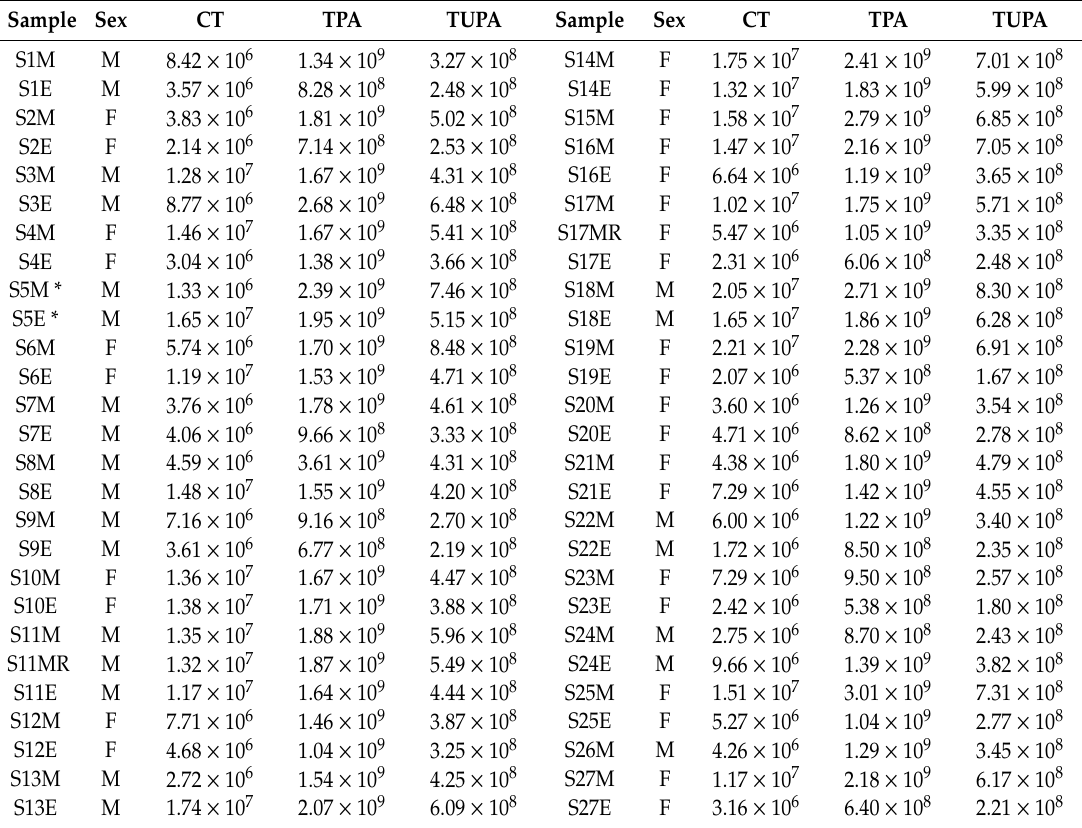
Table 1. Comparison of creatinine (CT) peak areas, TPA, and TUPA of 54 urine